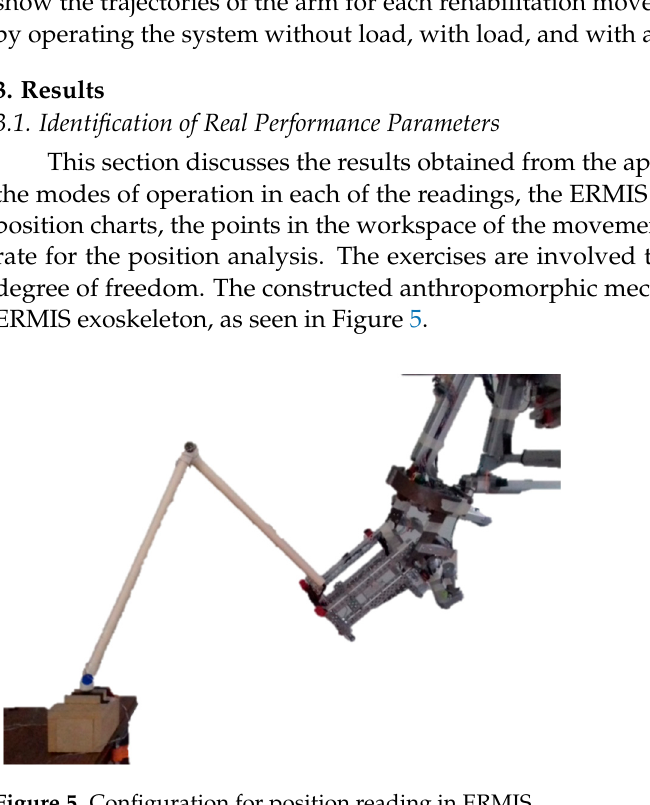
Table 4. Time per work cycle.